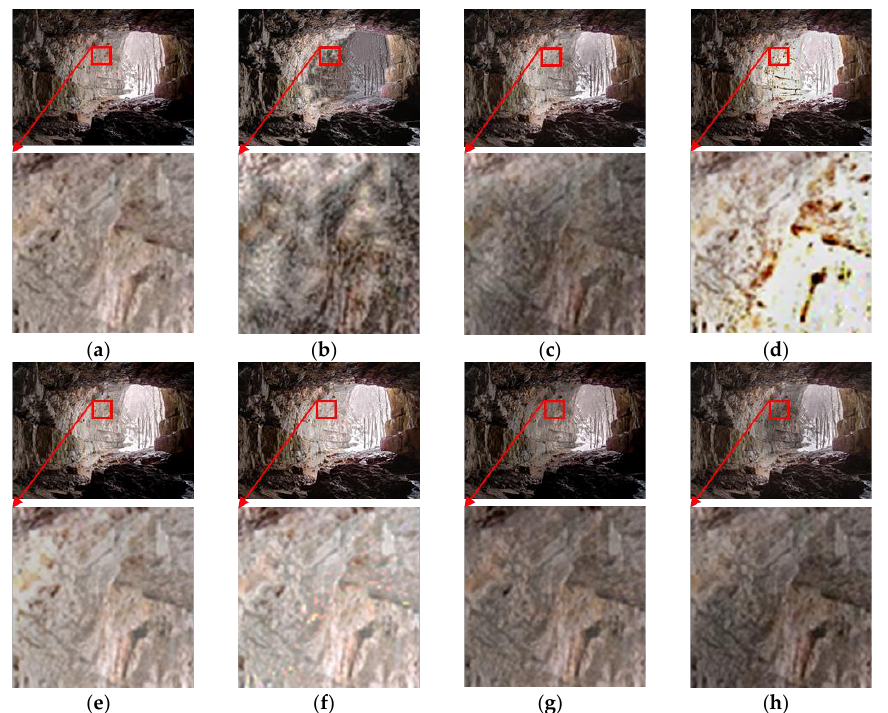
Figure 4. Four sets of multiple exposure image sequences. ( a ) ‘Cave’ image sequence . ( b ) ‘Lamp’ image sequence. ( c ) ‘ H ouse’ image sequence . ( d ) ‘Tower’ image sequence.